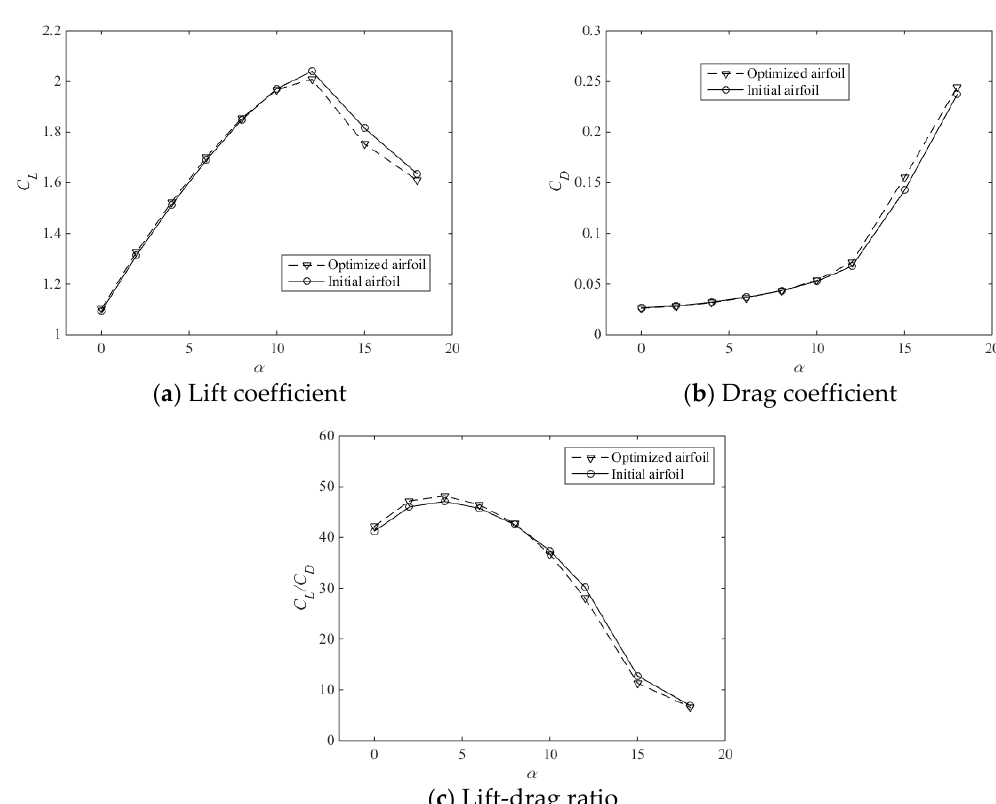
Figure 21. Comparisons of aerodynamic characteristics between the optimized airfoil and the initial S1223 airfoil.